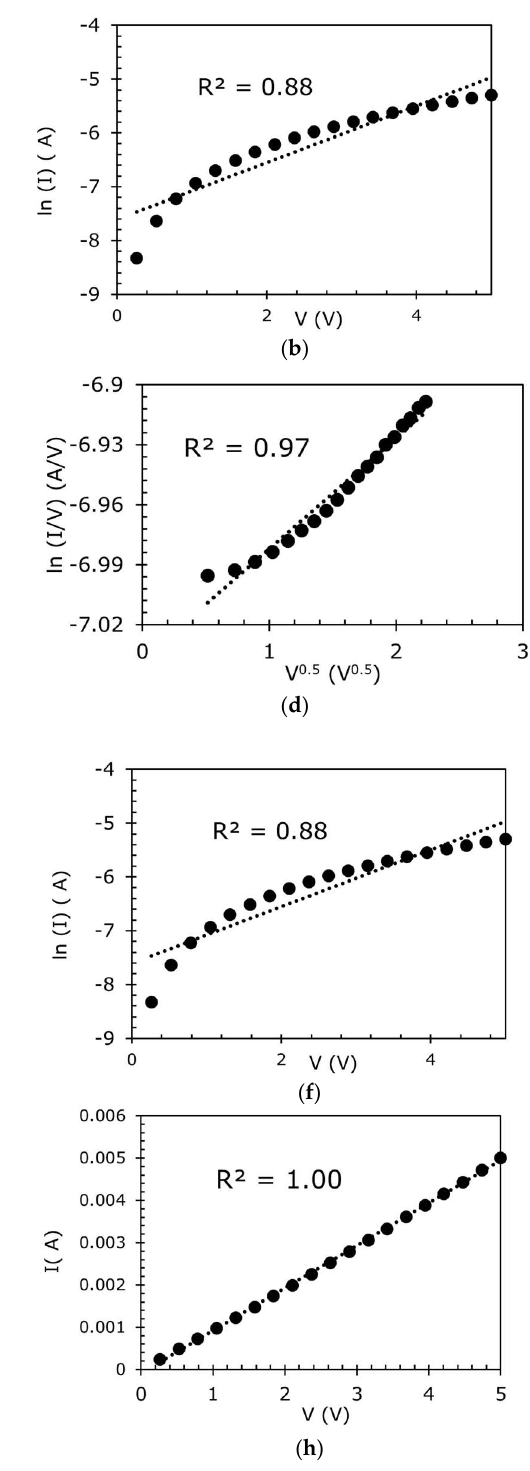
Figure 9. R versus T and I versus V curves of the sensor at 28.5 kPa (Region II) and their fit to ( a , b ) hopping conduction; ( c , d ) Poole–Frankel; ( e , f ) ionic conduction; ( g , h ), Ohmic conduction.